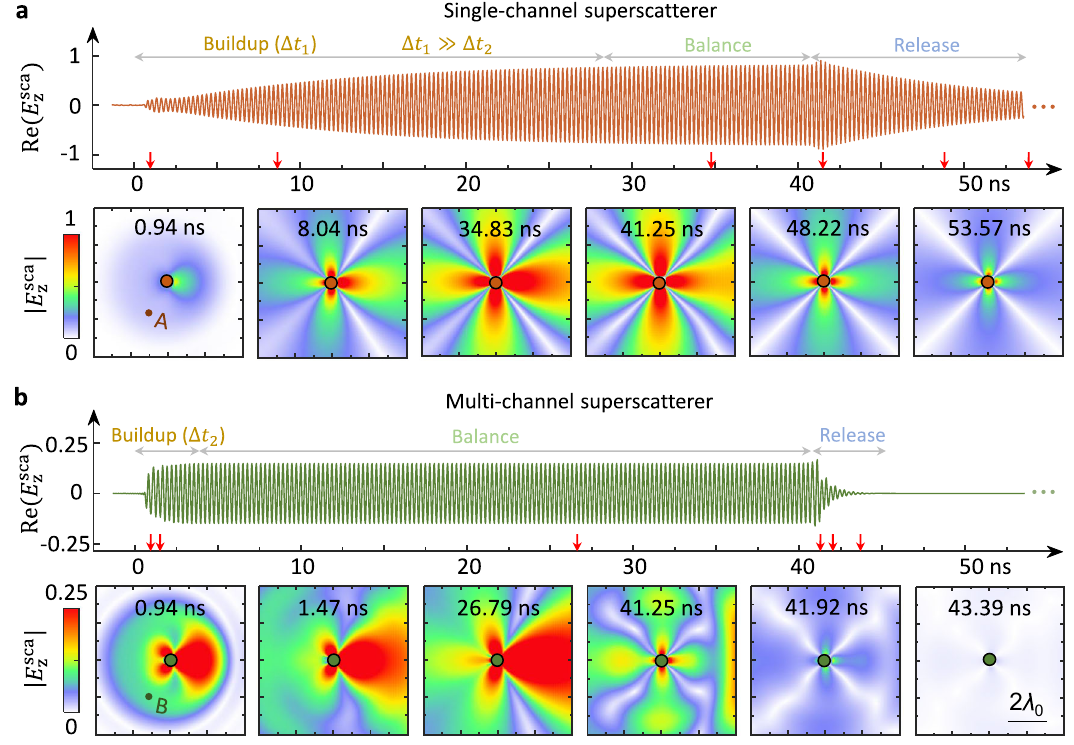
Fig. 2 | Transient response of the single-channel superscatterer in the time domain. Here,weconsidertheincidenceofatime-modulatedplanewavefromleft to right, which is modulated by a time window from 0ns to 40.18ns, as shown in Supplementary Fig. 8. The modulated frequency is 3.733GHz (with a period of 0.27ns), in accordance with the working frequency of the two superscatterers. a Time evolution of the scattered fi eld E sca z at point A (upper panel) and a region (lower panel) of the single-channel superscatterer. The whole temporal process